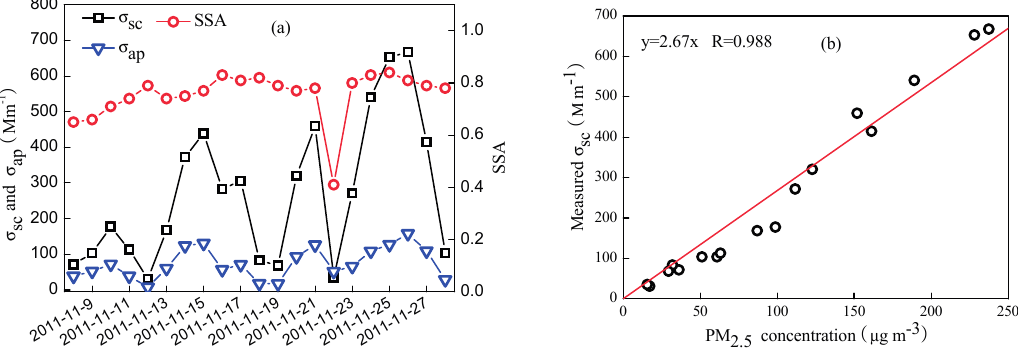
Figure 9. The time series of daily averaged aerosol optical properties ( a ) and relationship between the measured σ sc and PM 2.5 concentration ( b